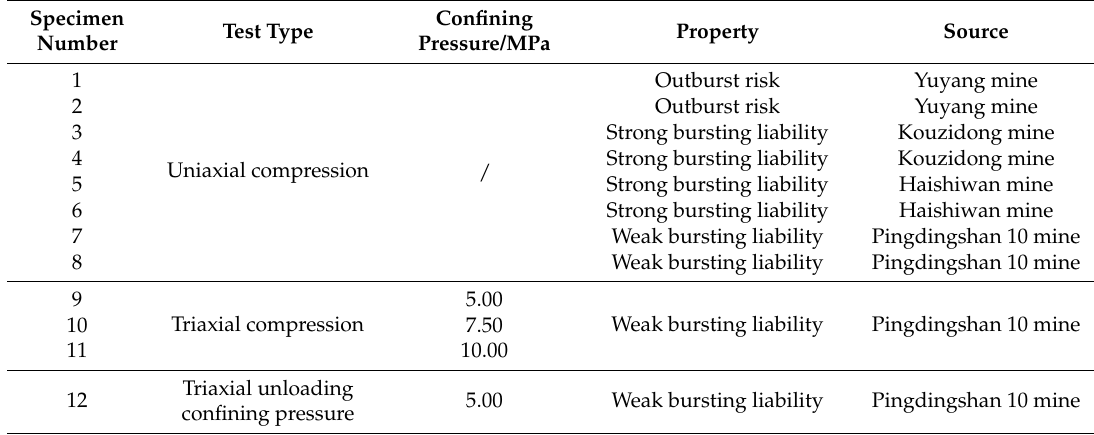
Table 1. Experimental scheme of coal specimens